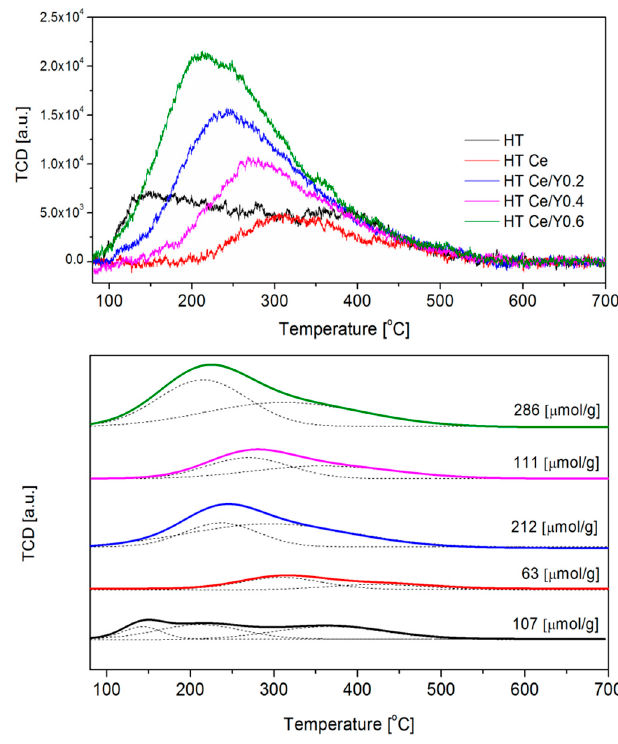
Figure 4. TPD-CO 2 plots for Ce- and Y-modified catalysts.